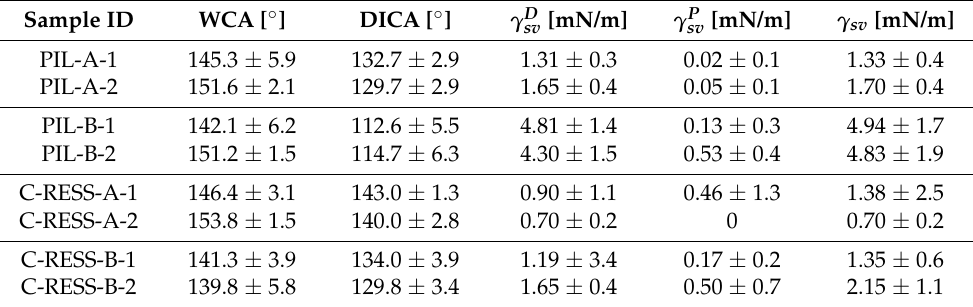
Table 3. Calculated surface free energy (SFE) values of the PIL and C-RESS micro-structures replicated with two different resins on PC foil, as measured by using water and